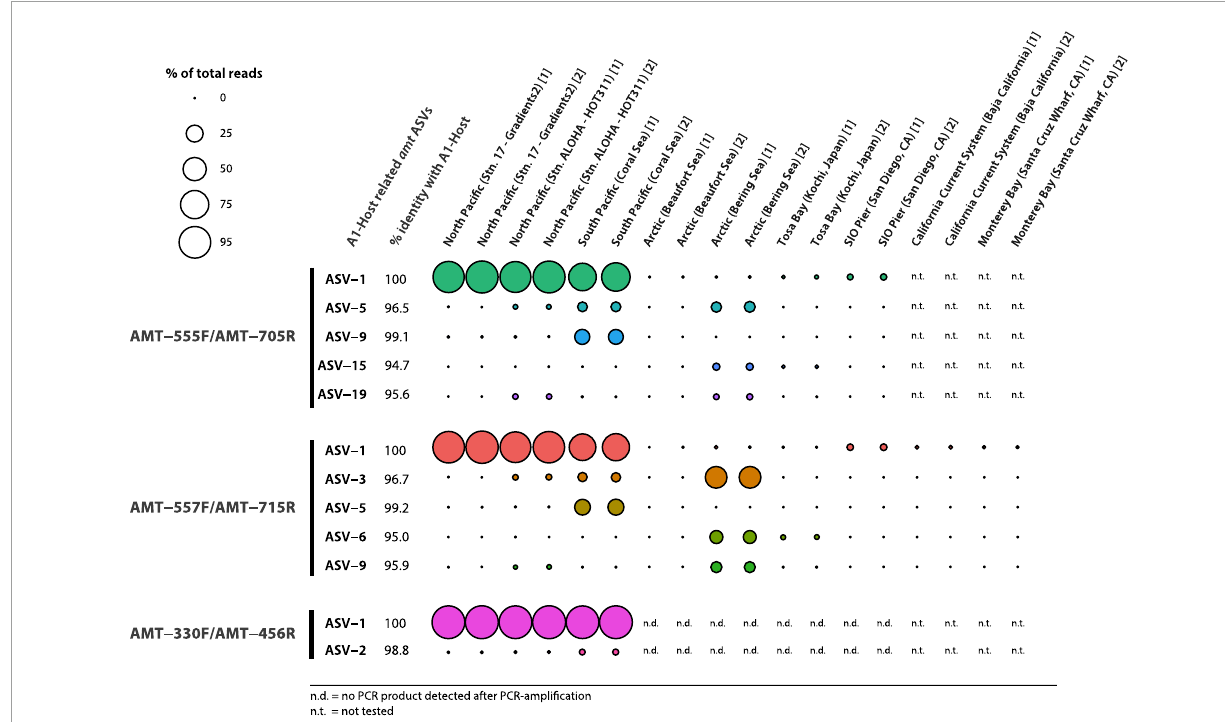
FIGURE2 Bubble chart representing the relative abundance of ASVs closely related to the A1-Host amt gene (red bars in Figure 1 ) across samples (technical replicates are indicated with numbers between brackets after the name of the samples). ASVs amplified by different primer pairs are indicated. Bubble size is determined by percent reads represented by every ASV within the same sample. Closely related ASVs and the percent identity shared with the A1-Host amt gene are shown as well as the % of reads captured in each of the tested